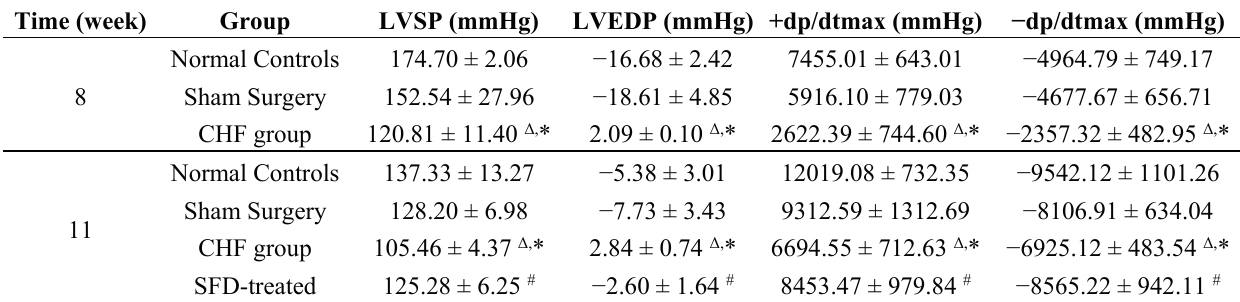
Table 1. Summary of hemodynamic data ( X ± s, n =